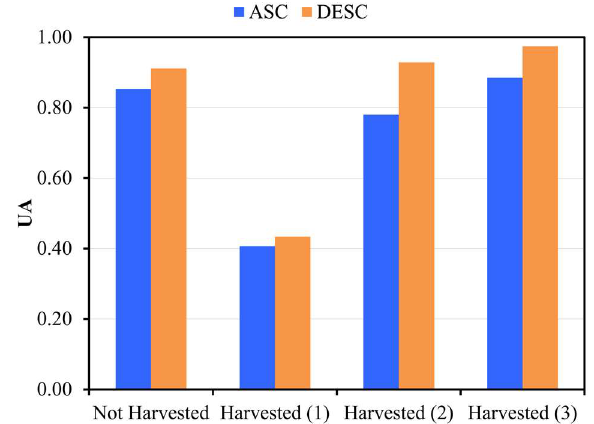
Figure 11 . UA values of different classes in the combined method using ascending and descending